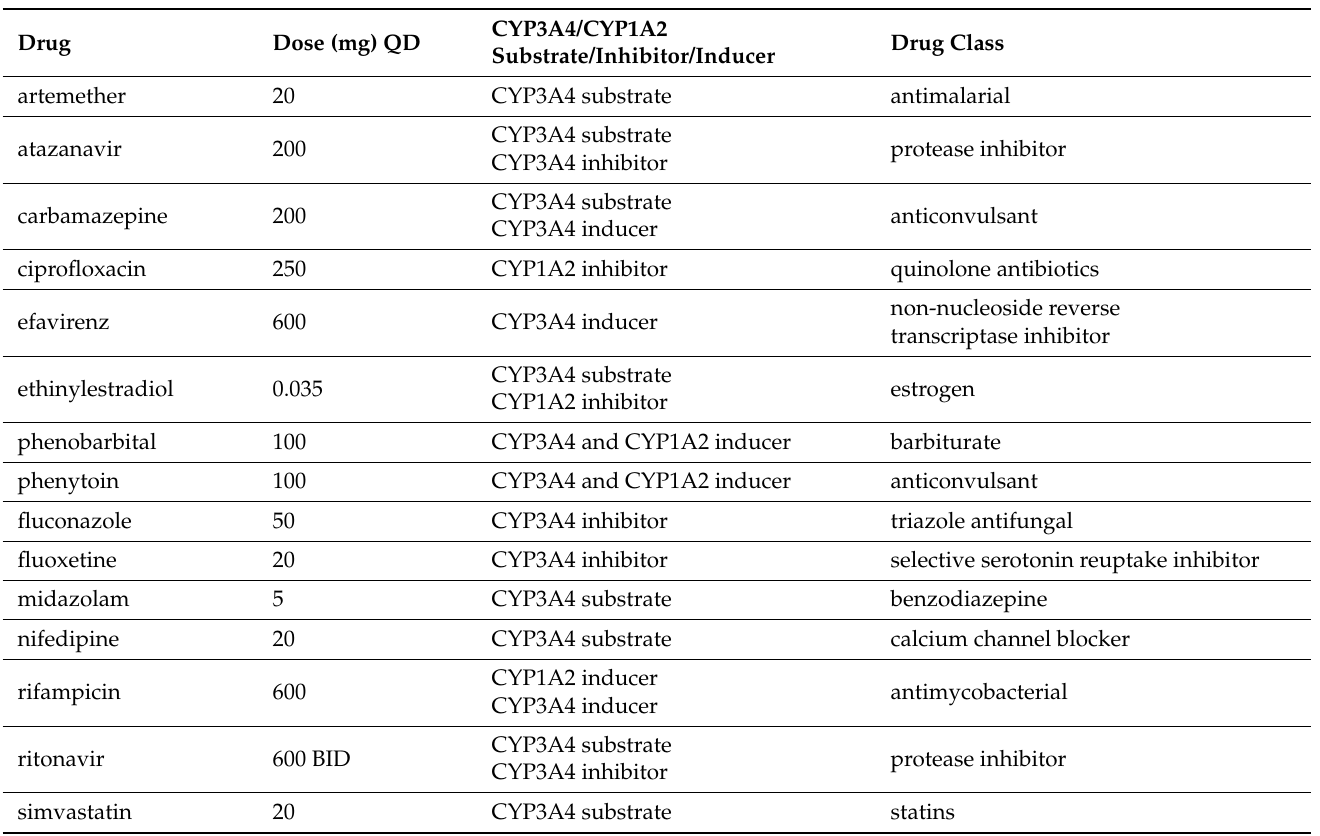
Table 4. Selection of the South African Essential Medicines list from WHO, used in SimCYP ® simulations with AFB1, the drug administration dose (mg), the CYP3A4/CYP1A2 substrate/inhibitor or inducer and the drug